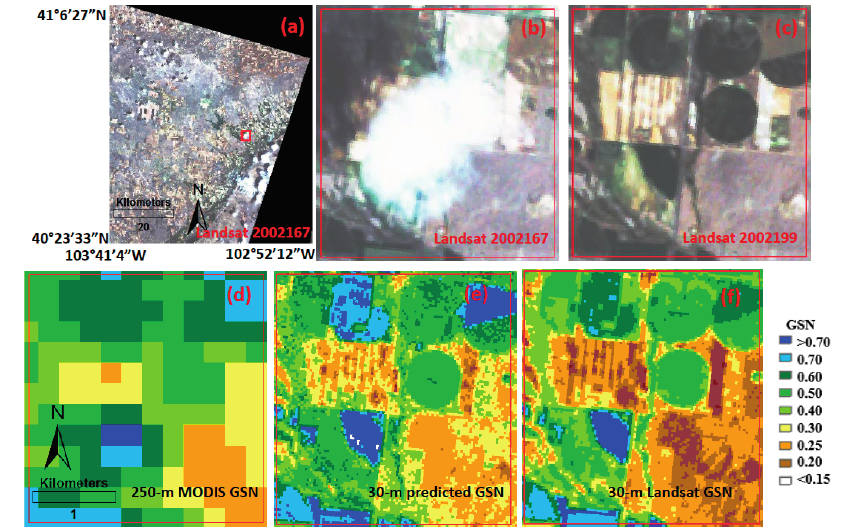
Figure 6. Illustration maps for a selected cloudy area. ( a ) Location of the selected cloudy area (red box); ( b ) Zoomed in Landsat scene for 2002 day of year (DOY) 167; ( c ) Zoomed in Landsat scene for 2002 DOY 199; ( d ) Zoomed in 250-m MODIS GSN; ( e ) Zoomed in 30-m predicted GSN; ( f ) Zoomed in 30-m original Landsat